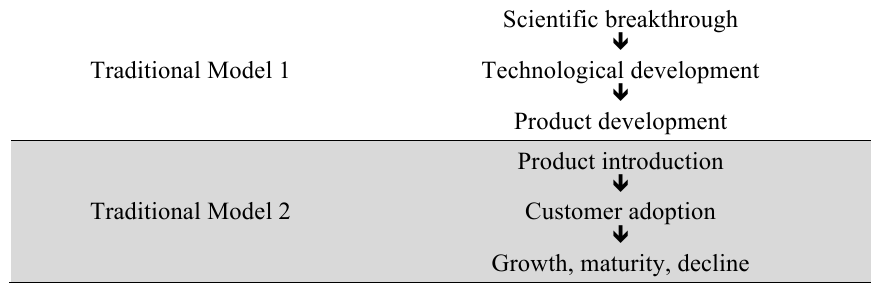
Table 1. Traditional linear models of